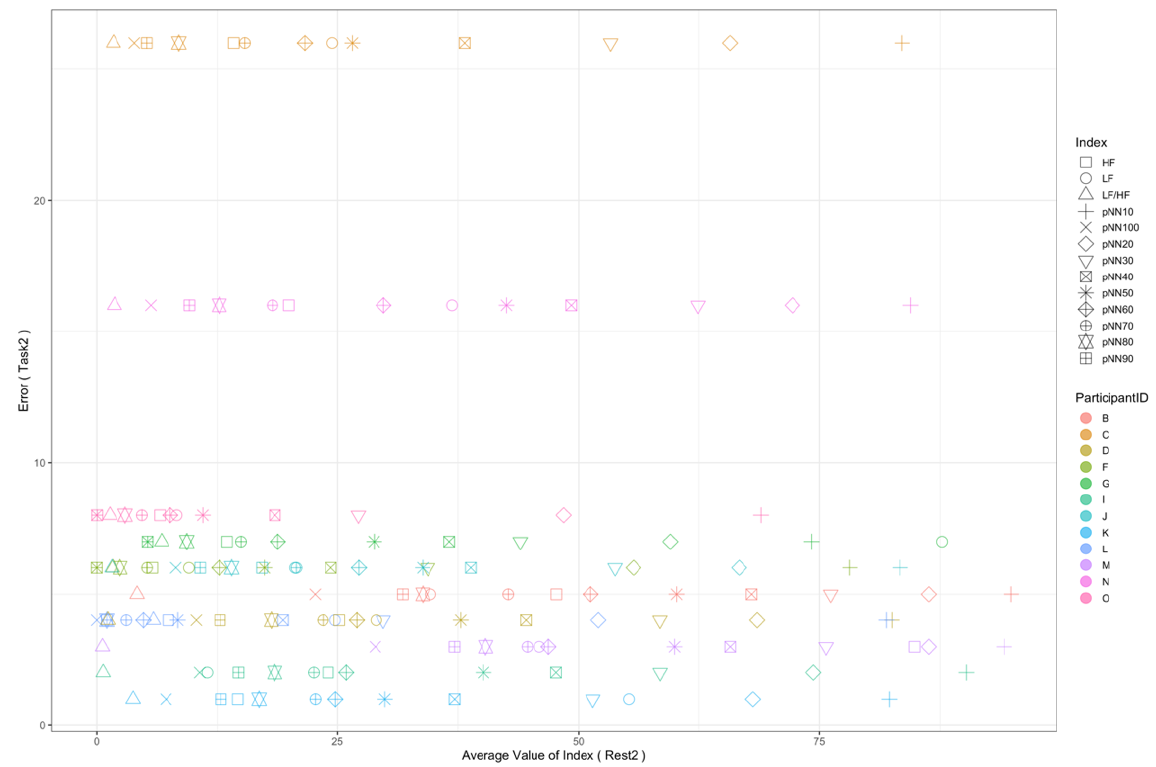
Figure 9. Scatterplot between the number of errors of Task2 vs. the HRV indexes during Rest2.